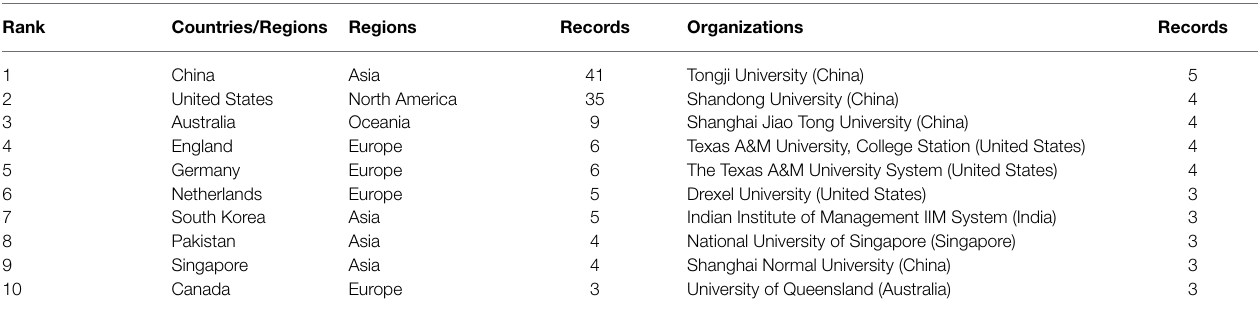
TABLE 4 | The top 10 most productive countries/institutions in UPB